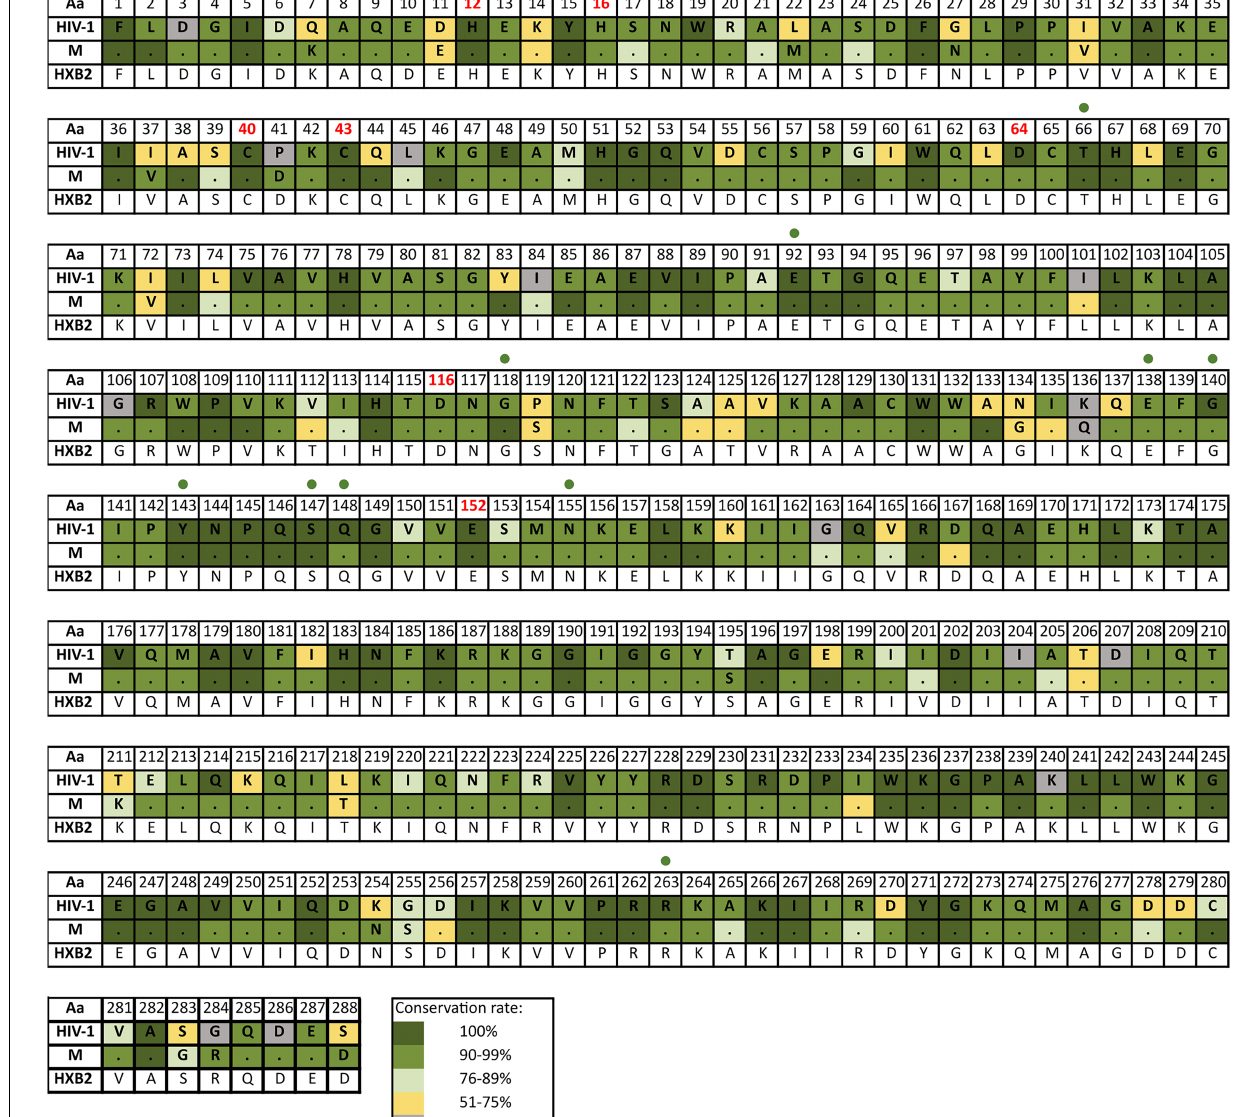
corresponded to R-markers: Four were detected in